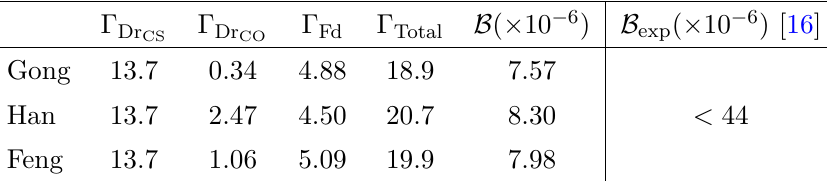
Table 2 . Decay widths of Z → Υ(2 S )+ X (in units of KeV). The subscripts “ Dr 00 and “ Fd 00 refer to the direct-production processes and feed-down effects, respectively. m b = 4 . 75 GeV and µ r = m Z / 2 .